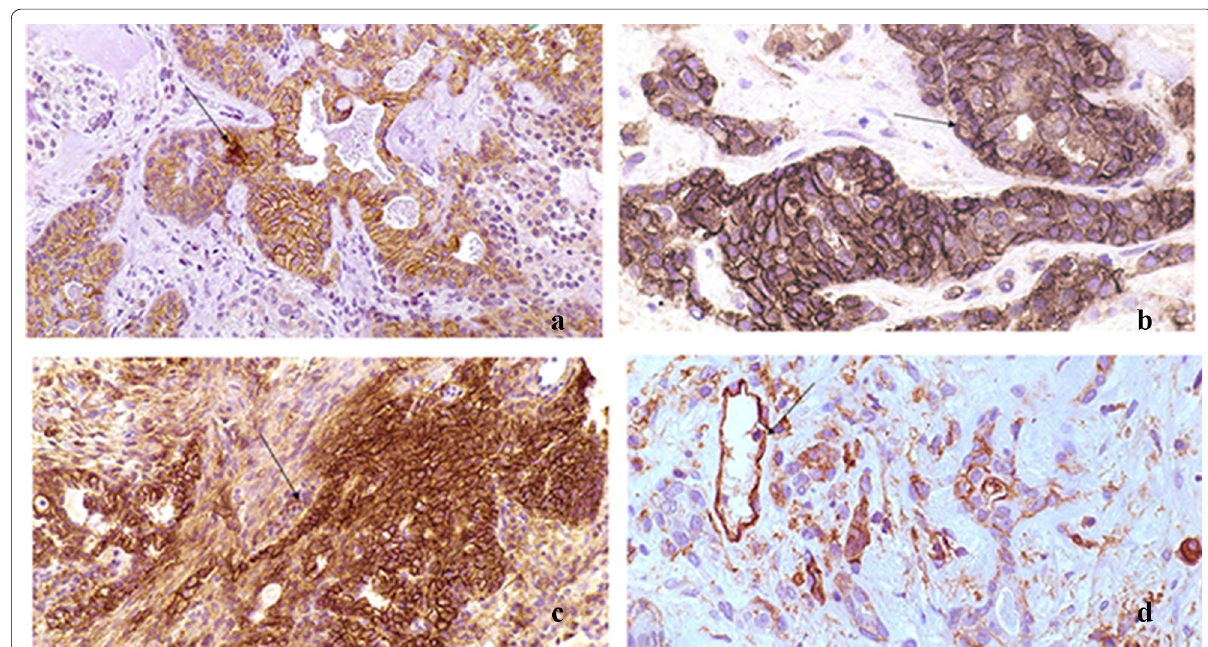
Fig. 2 Cell adhesion molecules in Pleomorphic Adenoma. a Dsg-2: Membranous or diffuse cytoplasmic staining at the intercellular contacts of neoplastic cells of all architecture types except luminal surfaces of luminal cells and basal surfaces of non-luminal cells. No positivity in stromal cells (Envision/HRP 100). b Beta4-integrin: Strong membranous positivity at cell-basal membrane contacts, intercellular connections of the × great majority of cells and stromal cells (Envision/HRP x200). c HCAM (CD44s): Strong membranous expression in the majority of neoplastic cells of all structures especially in stromal cells, cells of solid islands, non-luminal cells and intercellular contacts between luminal and non-luminal cells (Envision/HRP x200). d ICAM-1: Fibroblastoid stromal cells mainly in myxoid areas, linear positivity at the luminal surface of luminal ductal cells and